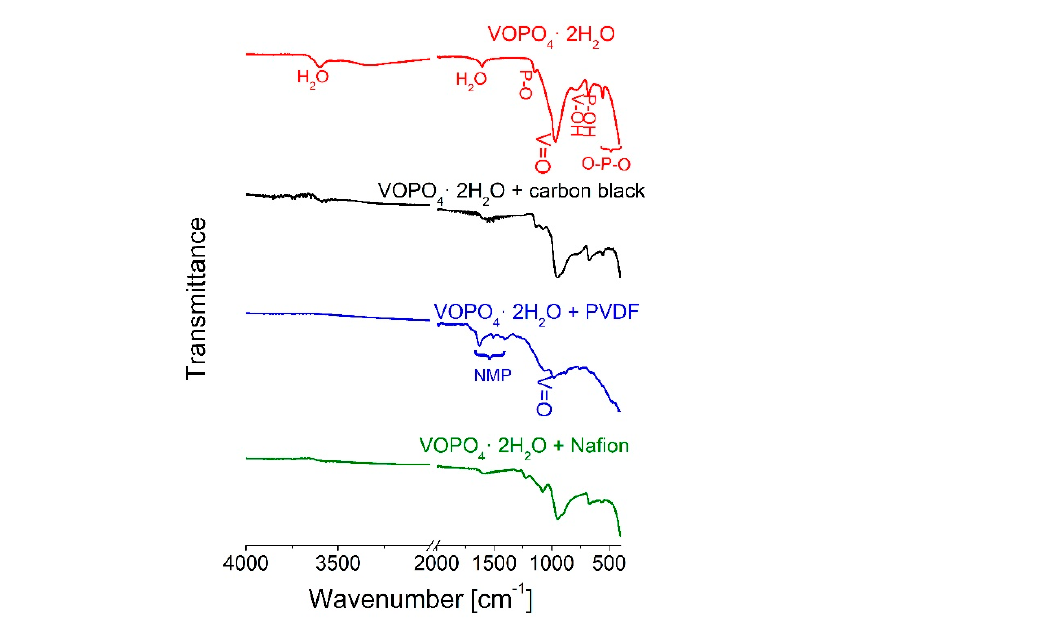
Figure 5. Comparison of FTIR spectra of the VOPO 4 ∙ 2H 2 O and its mixtures with carbon black, carbon black and PVDF, and carbon black and Nafion.